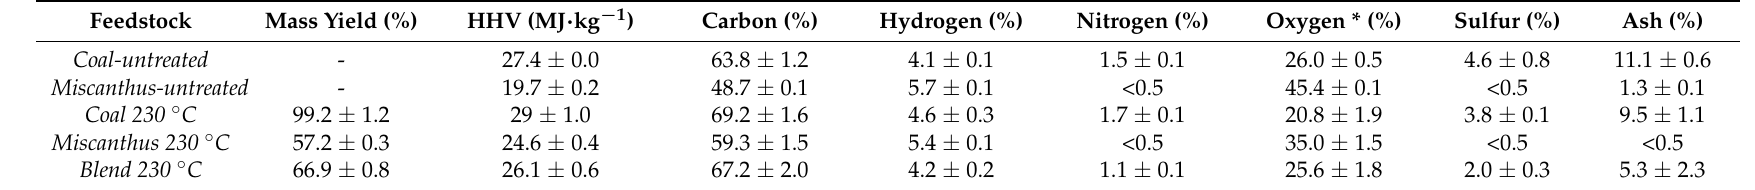
Table 1. Carbon, sulfur, and ash content of untreated feedstocks and hydrochars on a